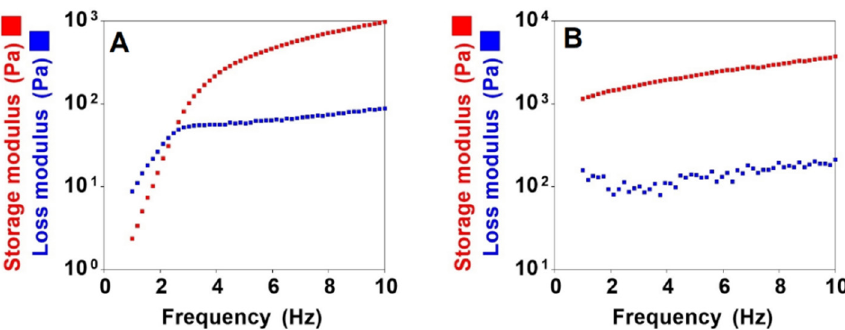
Figure 6. Oscillatory analysis of the HG@MSN-CCM: analysis performed at 25 °C ( A ) and analysis